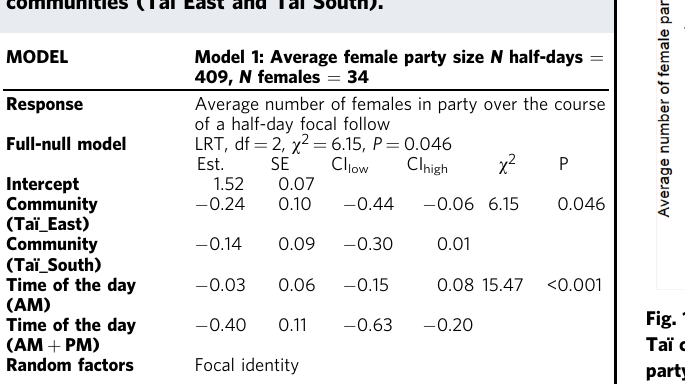
Table 1 Overview over structure and results of the models analyzing differences in female-female gregariousness between one bonobo (Bompusa) and two chimpanzee communities (Taï East and Taï